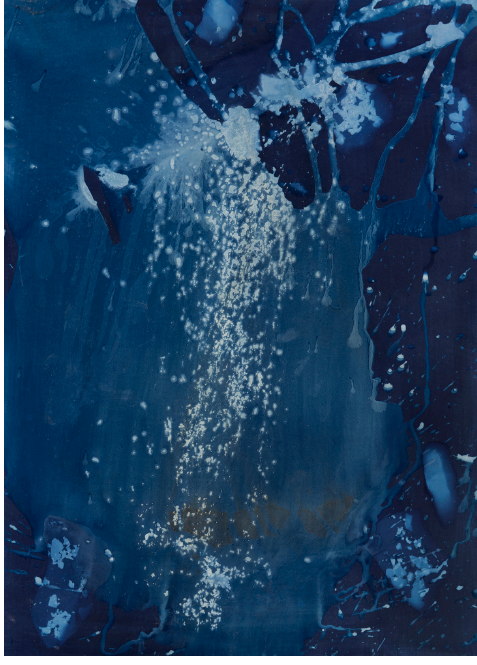
Figure 5: Downwaste (Sperry I), 2019. Cyanotype on paper 30" x 22". Courtesy of Jonathan Marquis. Downwaste gallery available at: